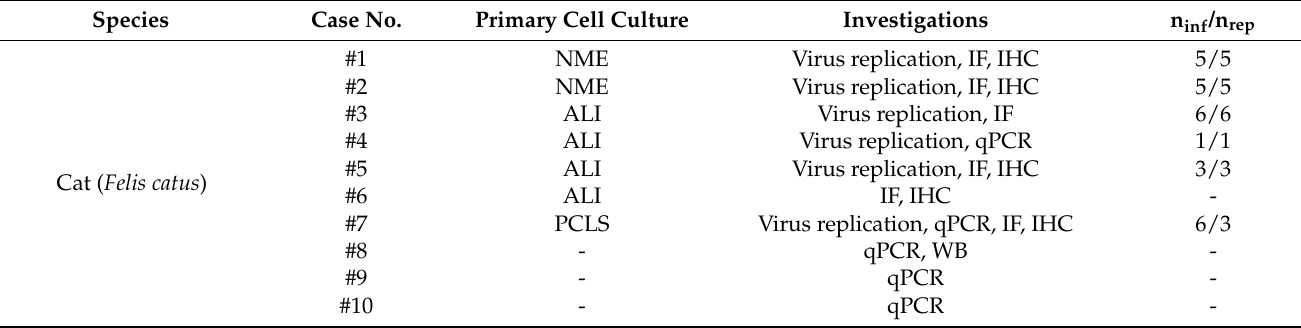
Table 1. Collection of felid samples for the generation of primary cultures, pathological, and biochemical examinations. Species Case No. Primary Cell Culture Investigations n inf /n rep